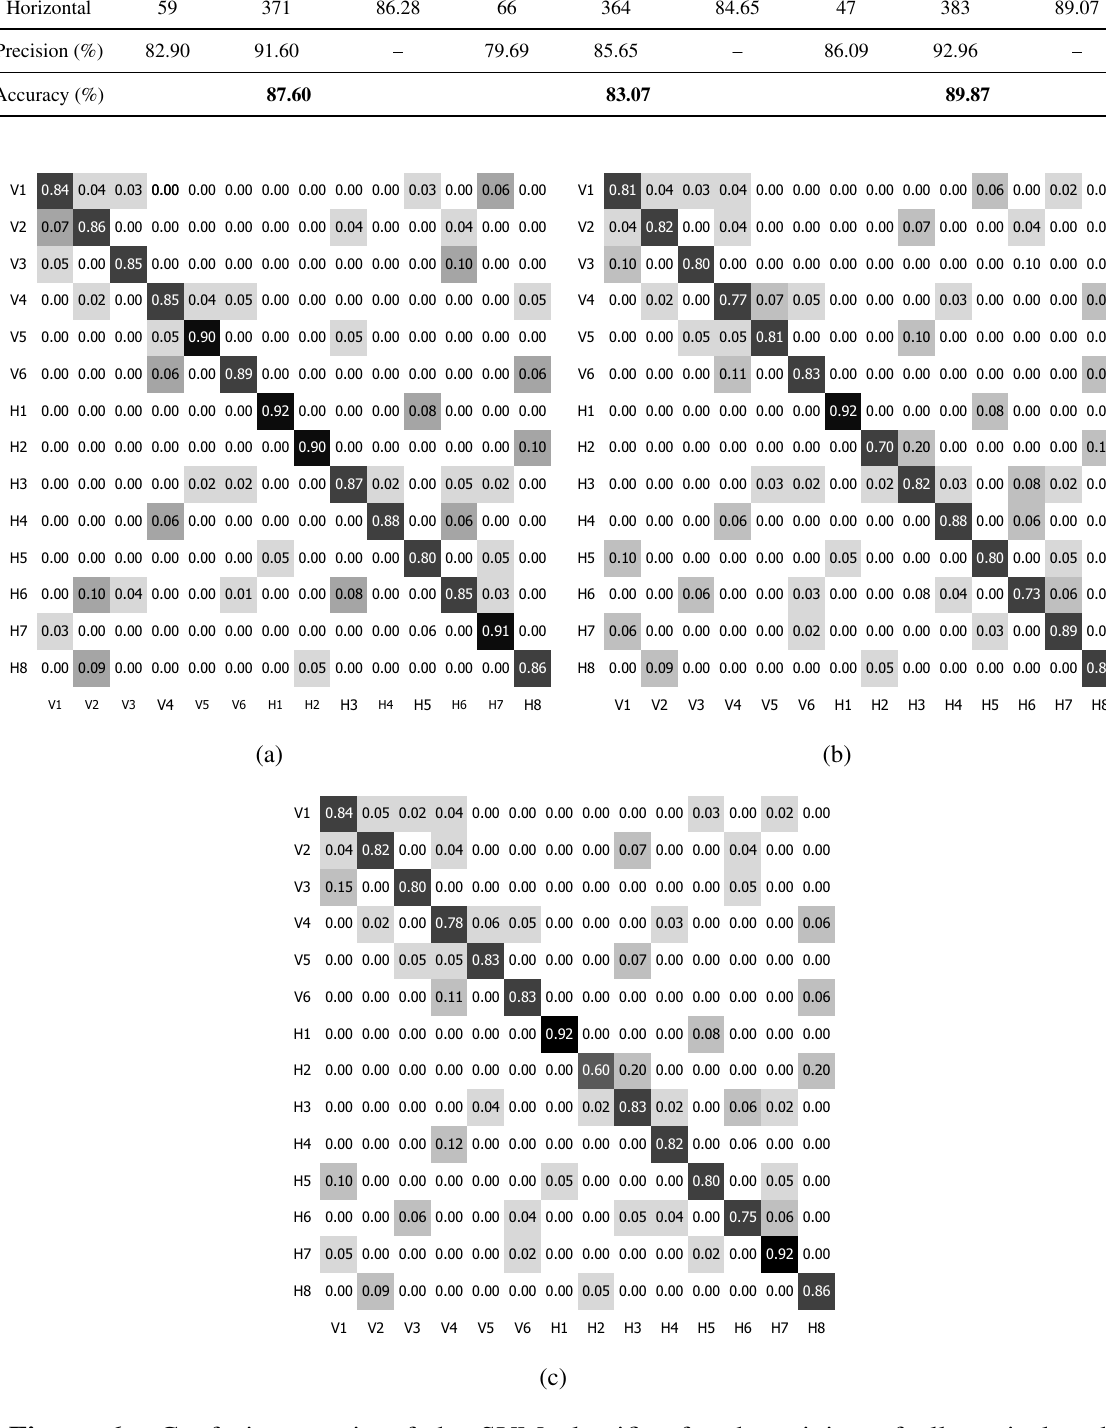
Figure 6. Confusion matrix of the SVM classifier for the mixing of all vertical and horizontal traffic with overall classification accuracy: ( a ) PAM 86.4 % ; ( b ) LDA 80.4 % ; and ( c ) MCTM 81.6 %